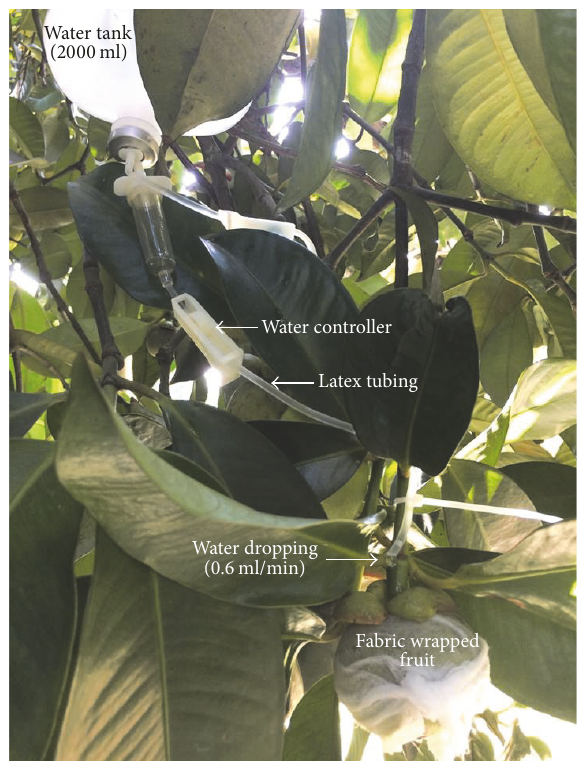
Figure 1: Water applying apparatus for on-tree mature green mangosteen